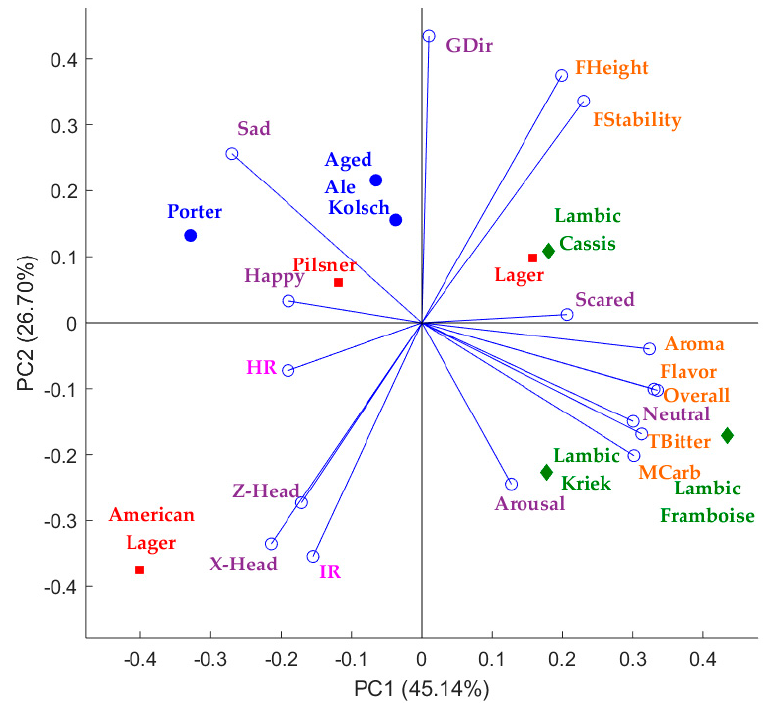
Figure 8. Multivariate data analysis showing the principal components analysis where: IR = body temperature, HR = heart rate and head orientation in x - ( X -Head), y - ( Y -Head) and z - ( Z -Head) axes.